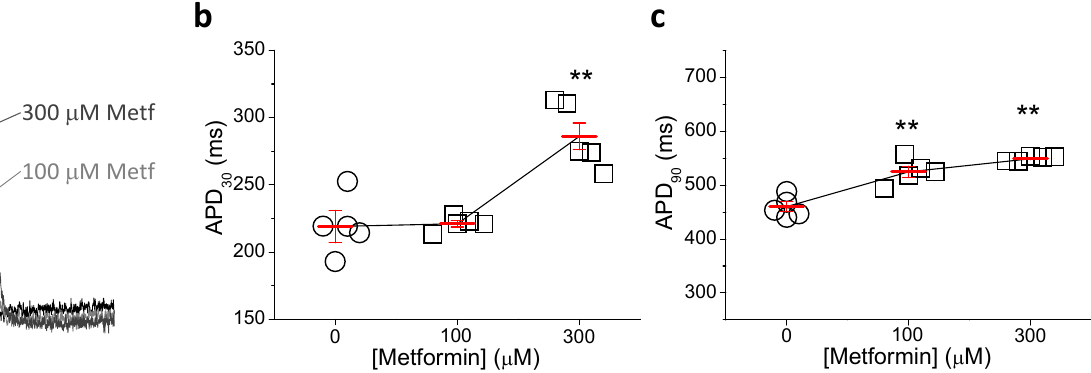
Figure 7. Metformin prolongs action potential duration in hIPS-CMs. ( a ) Representative AP traces obtained from hiPSC-CMs incubated with vehicle, or 100 and 300 µ M metformin for 24 h. ( b , c ) Dose- dependent effect of metformin on APD at 30 and 90% of repolarization (n = 5). Points represent individual data with mean ± SEM (red marks). ** p < 0.01 compared to